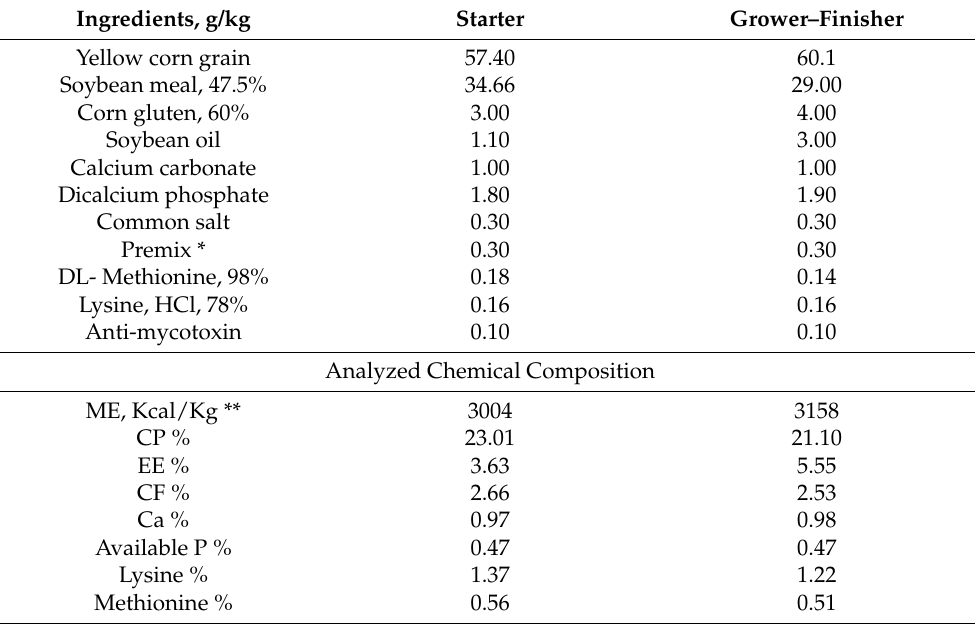
Table 1. Ingredients and chemical composition of the basal diet (as dry